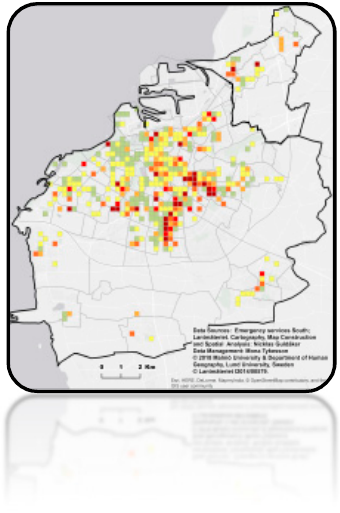
Figure 10. Choropleth map - grids.